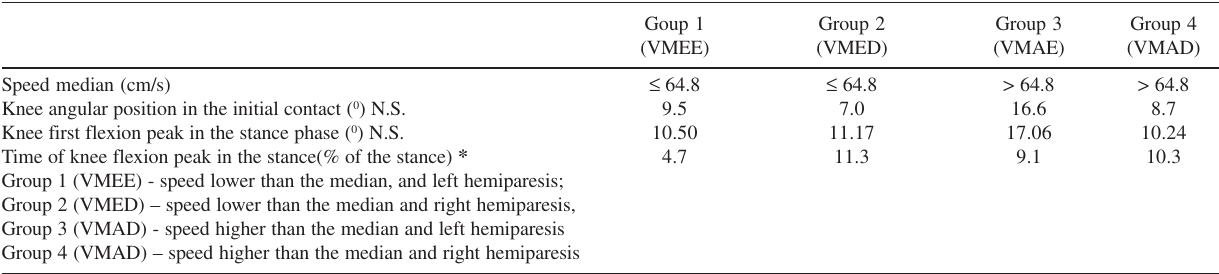
Table 1 - Speed median value and mean value of the kinematic variables of knee joint of patients with ischemic brain stroke sequela